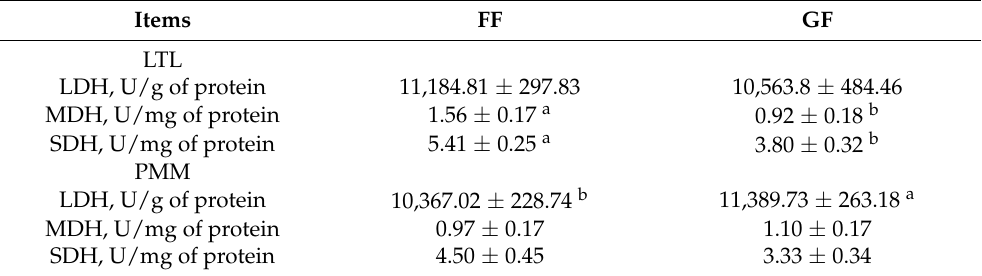
Table 4. Activities of muscle metabolic enzymes in the longissimus thoracis et lumborum (LTL) and psoas major muscle (PMM) under different rearing conditions in Heigai